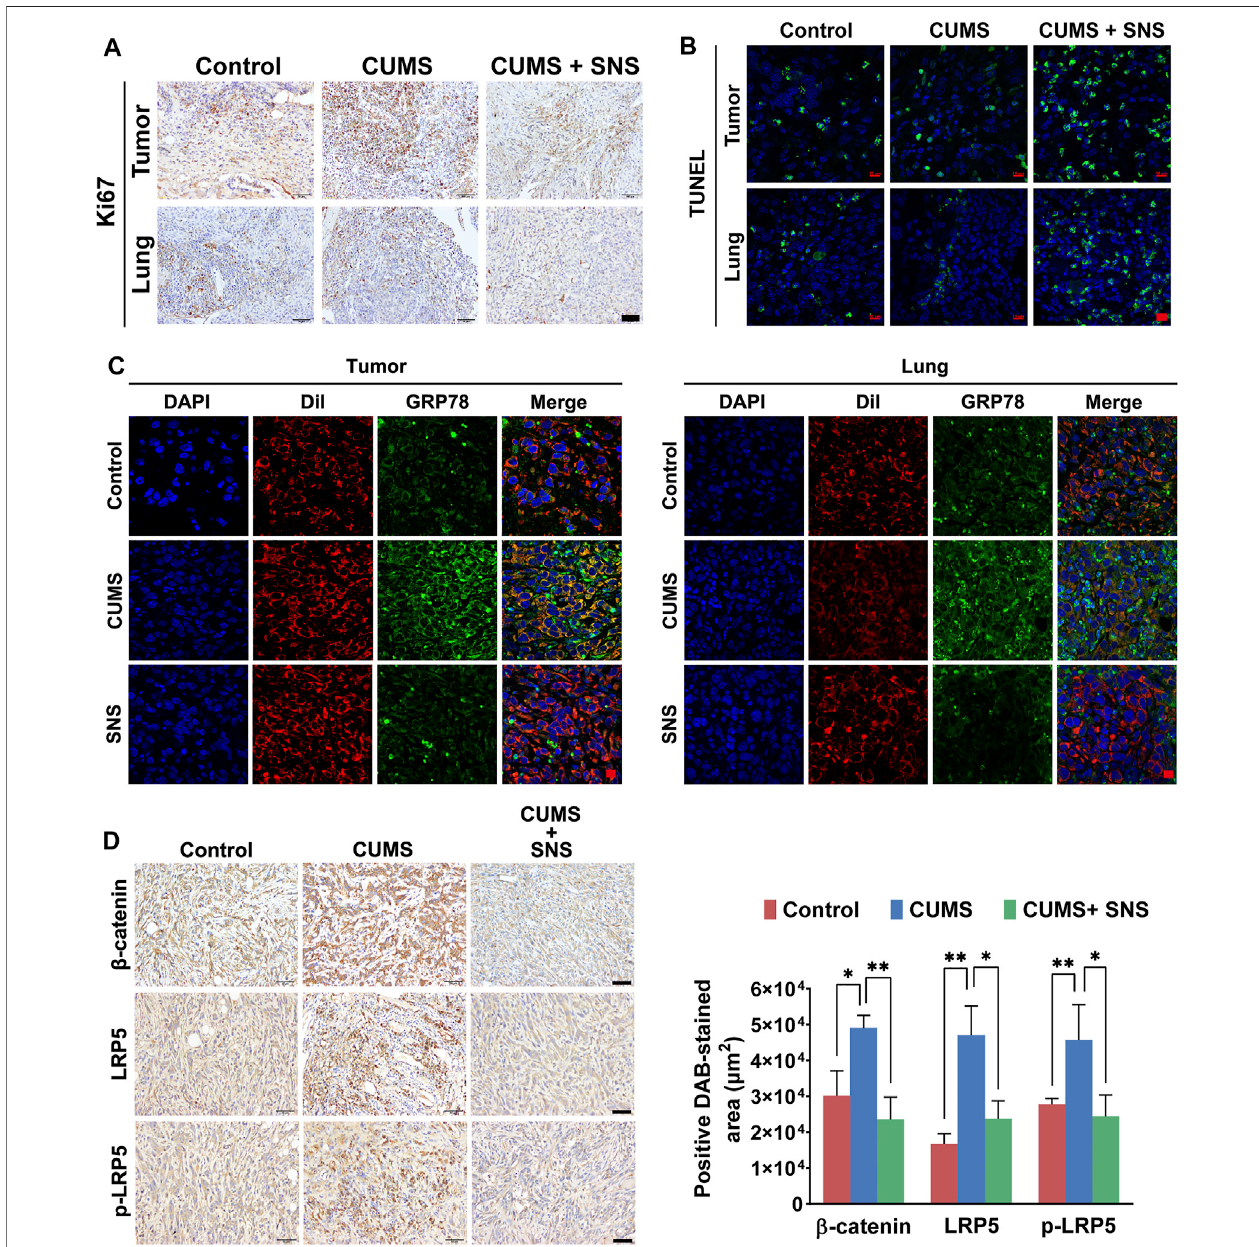
FIGURE7| SNSinhibitsCUMS-activatedWnt/ β -cateninsignalinginprimaryandmetastaticlesionsofbreastcancerinmice. (A) TheexpressionofKi-67inprimary and metastatic lesions of the 4T1 tumor-bearing mice was detected by immunohistochemistry, re fl ecting the proliferation of breast cancer cells in vivo (the scale bars indicate 50 μ m). (B) The TUNEL assays were used to detect in situ apoptosis in primary and metastatic lesions of the 4T1 tumor-bearing mice (the scale bars indicate 10 μ m). (C) Membrane expression ofGRP78intheprimary andmetastatic lesionsofthe4T1tumor-bearingmice wasdetectedbyimmuno fl uorescence(the scale bars indicate 10 μ m). Red: DiI-cell membrane tracker; green: GRP78. Co-localization of GRP78 and the cell membrane is shown as yellow fl uorescence. (D) The expression levelsofLRP5, p -LRP5,and β -cateninintheprimarytumorsweremeasuredbyimmunohistochemistry(thescalebarsindicate50 μ m).Dataarerepresented as the mean value ± SD. One representative experiment of three independent experiments is displayed. One-way ANOVA and Bonferroni ’ s post hoc test were applied.